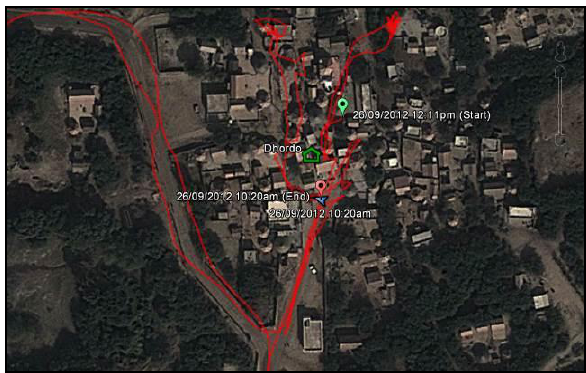
Figure 12. Route maps via Google Tracks